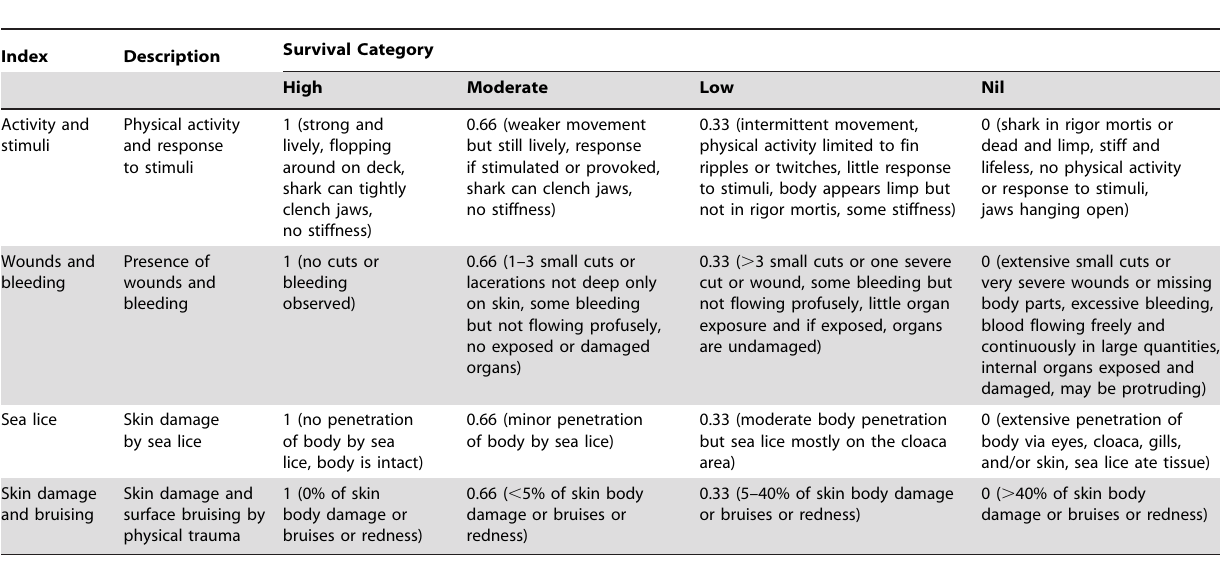
Table 1. Description of the score values of the indices used for the estimation of PCS for four arbitrary survival